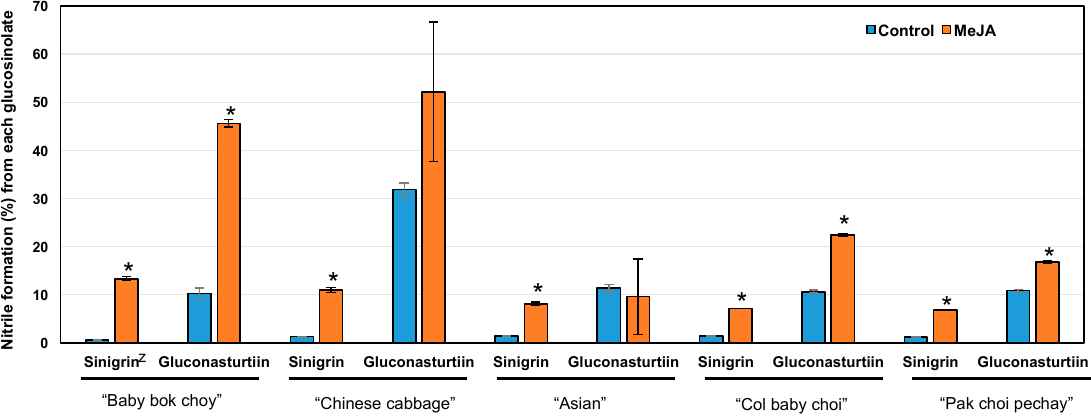
Figure 3. Nitrile formation (%) of control and MeJA-treated pak choi. Nitrile formation (%) is shown as the relative ratio of nitrile to the total hydrolysis product formed (sum of isothiocyanates and nitriles). Data are presented as the mean concentration ± standard error ( n = 3). Asterisks (*) above the error bar indicate a significant difference between treatments within same glucosinolates substrate by Student’s t -test at p ≤ 0.05. z Substrate glucosinolate used in the estimation of nitrile formation activity [nitrile percentage (%) out of total hydrolysis products].